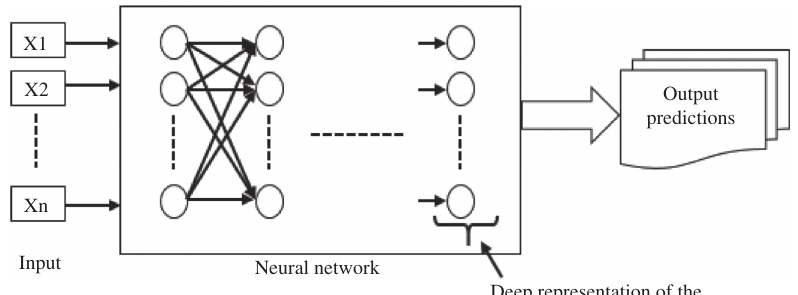
Figure 1: Block Diagram of Neural